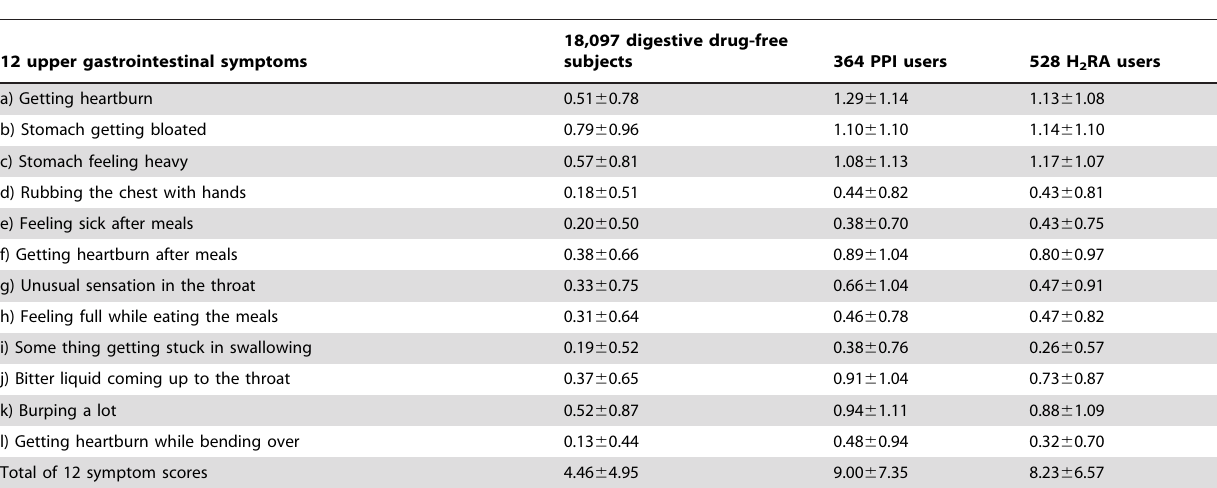
Table 1. Scores of the typical 12 upper GI symptoms among the 18,097 digestive drug-free subjects, 364 PPI users, and 528 H 2 RA